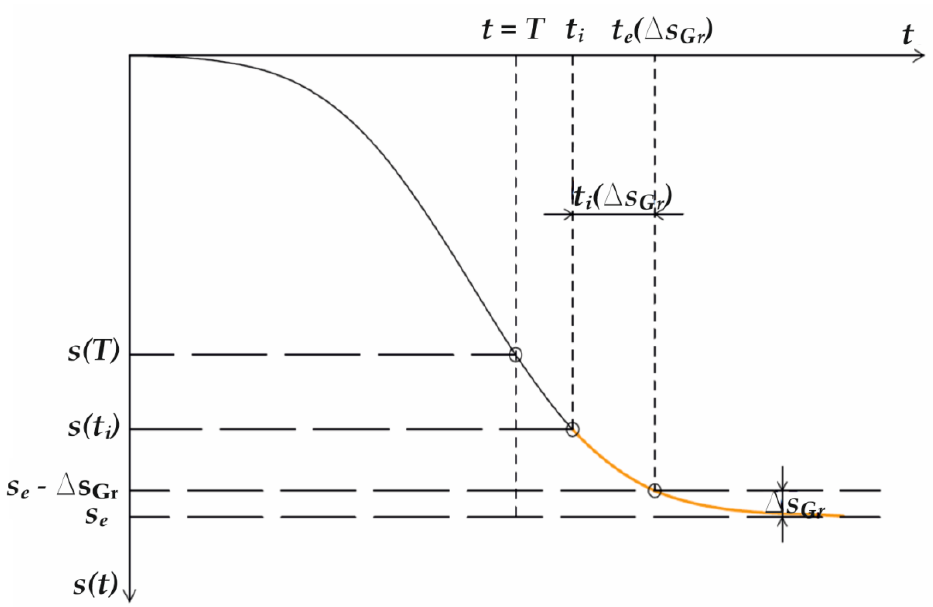
Figure 5. Graphical presentation of how the residual subsidence time t e ( ∆ s Gr ) is determined for a specific value of ∆ s Gr